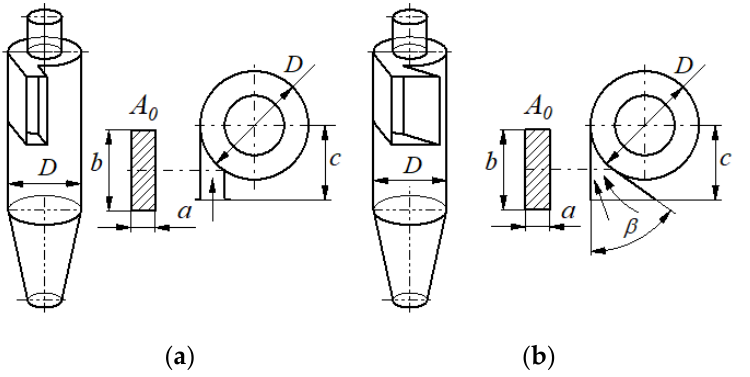
Figure 26. Modification A of cyclone D -40 design: ( a ) original (symmetrical) inlet channel shape and ( b ) asymmetrical inlet channel — Version W1.